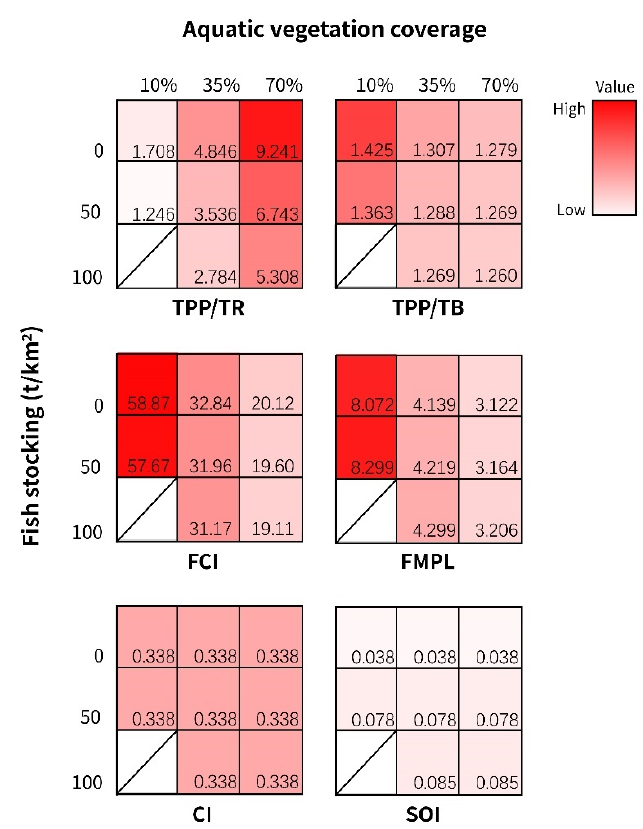
Figure 5. Several key indicators across 9 scenarios of aquatic vegetation coverage and fish stocking. TPP / TR: total primary production / total respiration; TPP / TB: total primary production / total biomass; FCI: Finn’s cycling index; FMPL: Finn’s mean path length; CI: connectance index; SOI: system omnivory index. The ‘ / ’ represents the model imbalance under this scenario.